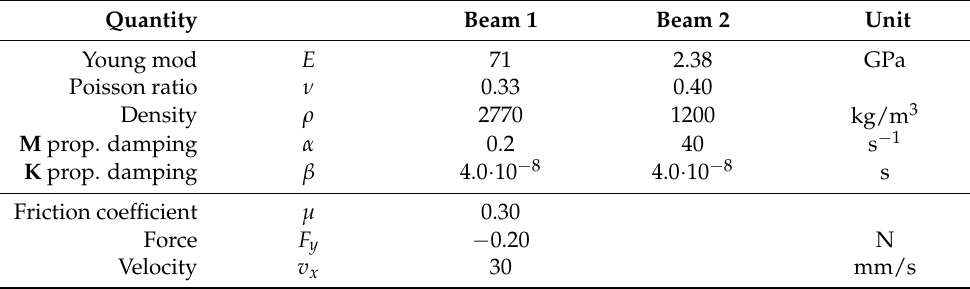
Table 2. Mechanical properties and boundary conditions of the